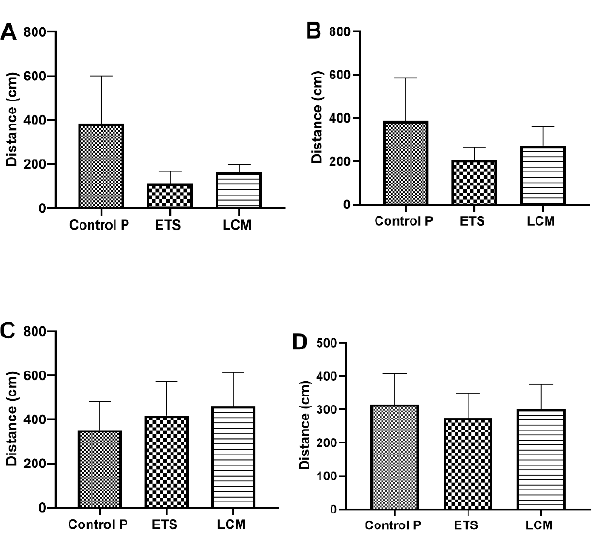
Figure 4. The impact of long-term treatment with ETS and LCM on cumulative distance after PILO induced SE in mice.( A ) Target quadrant IQ; ( B ) Left quadrant IIQ; ( C ) Opposite quadrant IIIQ; ( D ) Right quadrant IVQ. The activity was measured on the probe trial of the Morris water maze test. The multiple comparisons. Each bar represents the mean for five mice; error bars are S.E.M. ( n =